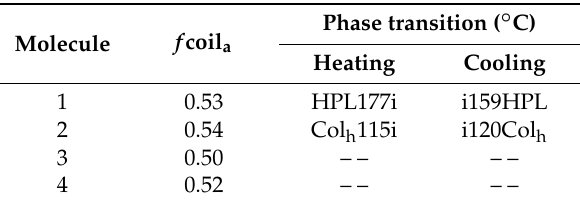
Table 1. Thermal transitions of molecules 1 and 2 (data are from the second heating and the first cooling